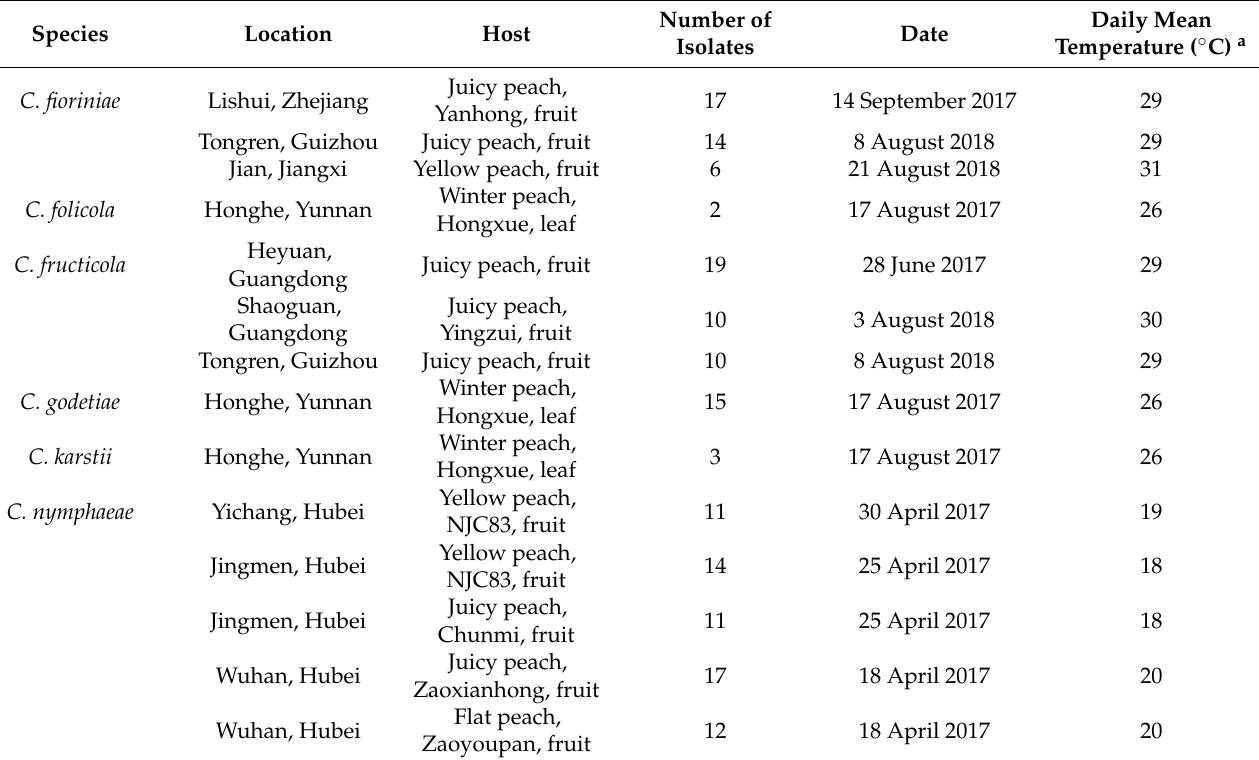
Table 6. A list of all Colletotrichum isolates collected from peaches in China based on preliminary